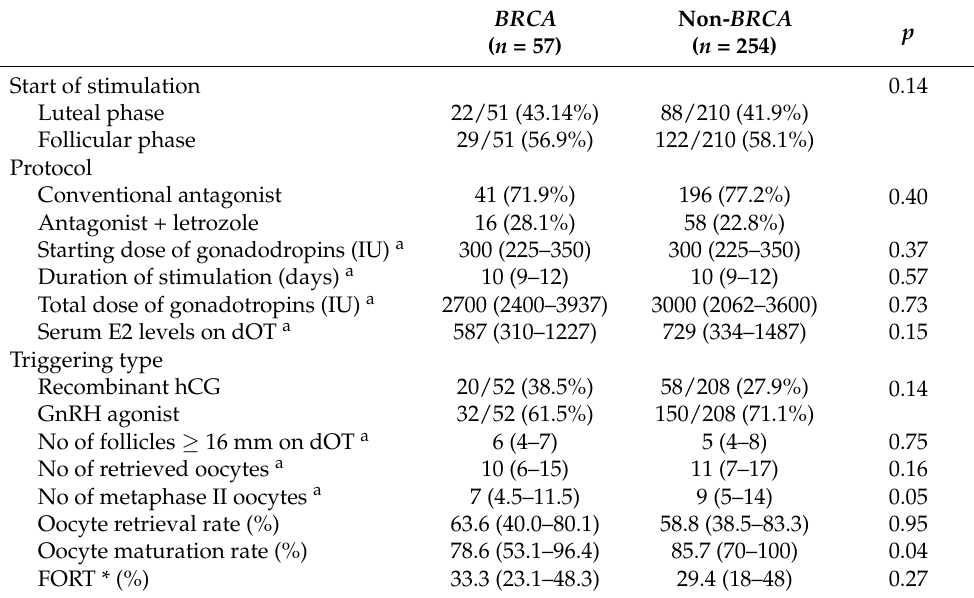
Table 2. COH characteristics and outcomes.